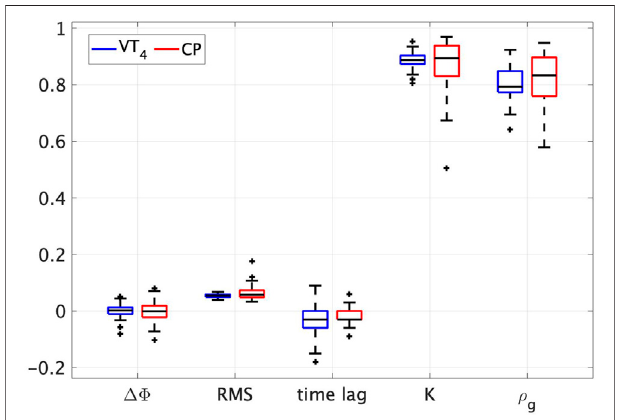
FIGURE 4 | Boxplots of the metrics used to validate the CP. Two boxplots are shown for each metric used to validate the learning algorithm (relative phase, RMS position error, time lag, max cross-covariance and synchronisation index). In blue those of the VT 4 , in red those of the